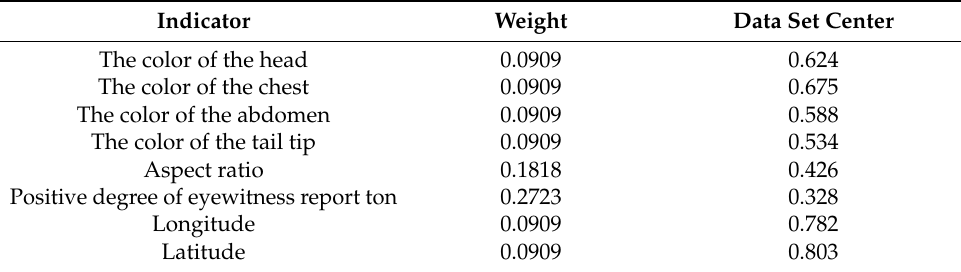
Table 2. The weights of indicators and the corresponding indicator data set